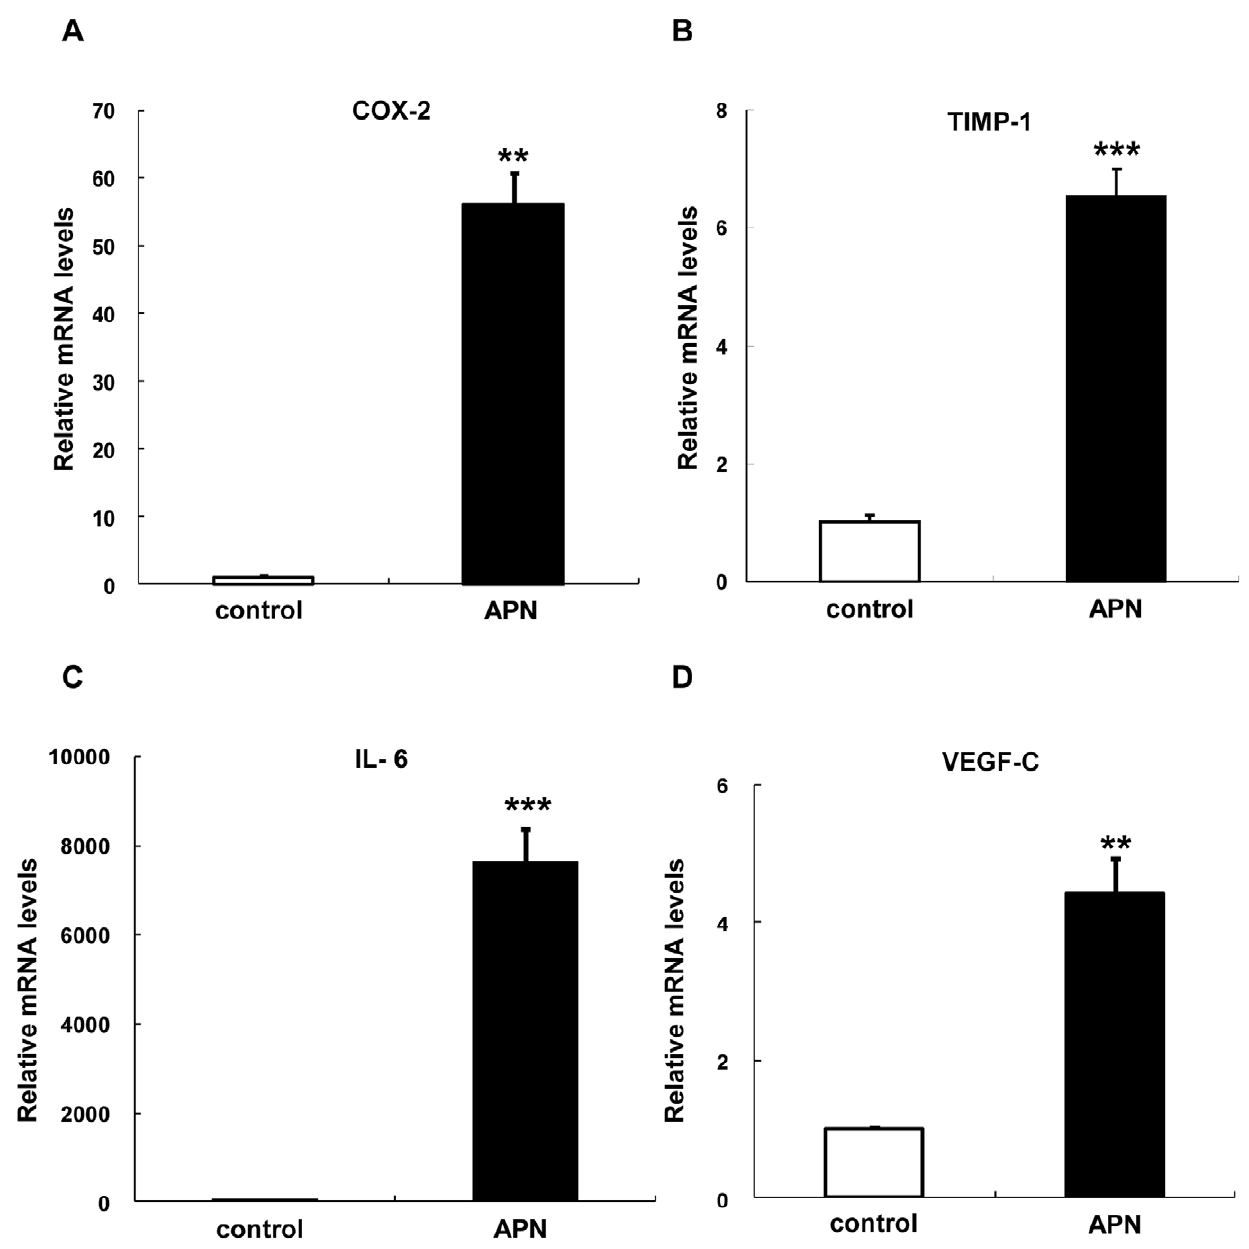
Figure 1. Effects of adiponectin on mRNA expression levels of various genes in peripheral blood monocyte-derived macrophages (PBDMs). After incubation for 7 days, mature human PBDMs were incubated for 6 hours with 10 m g/ml of adiponectin protein. The mRNA expression levels of COX-2 (A), TIMP-1 (B), IL-6 (C), and VEGF-C (D) were quantified by real-time PCR. Values are normalized to the level of GAPDH mRNA and expressed as mean 6 SEM (n=3). **P , 0.01, ***P ,